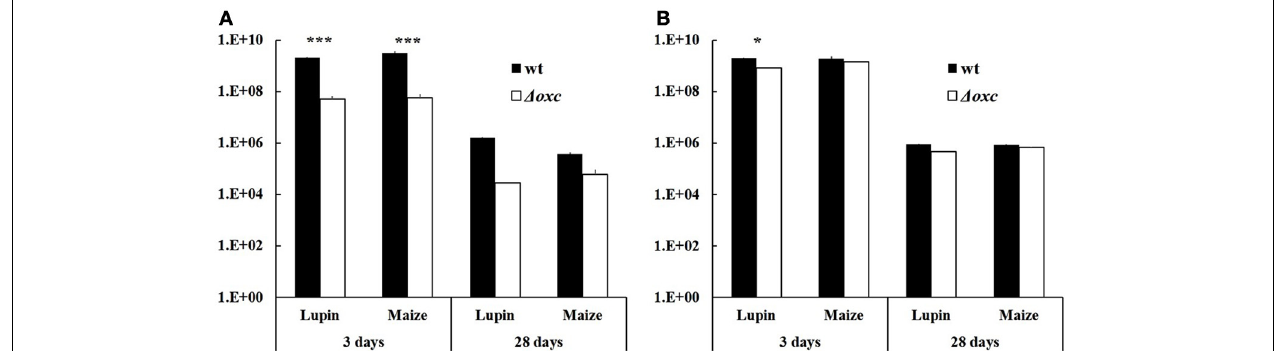
FIGURE 3 | Abundance of B. phytofirmans PsJN wild-type and (cid:2) oxc mutant after seed germination (3 days) and after one-month microcosm cultivation in vermiculite (28 days). Seeds were either bacterized with one strain (single inoculation, A ) or with a 1:1 mixture of wt and (cid:2) oxc mutant (dual inoculation, B ). Results are expressed as CFU per seed after 3 days and